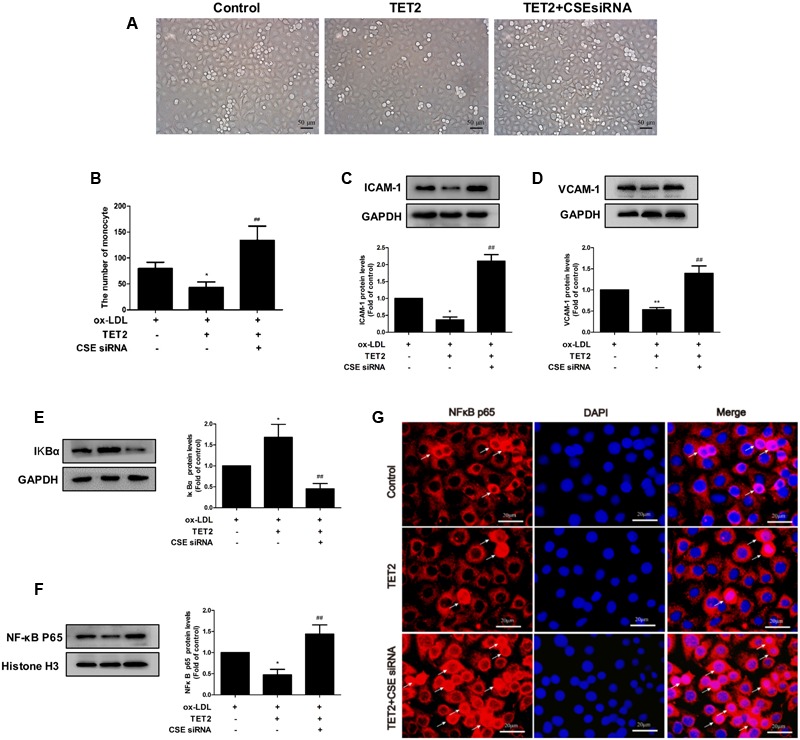
Effects of the CSE/H2S system on the TET2-induced improvement of oxLDL-treated dysfunction of HUVECs. HUVECs were transfected with or without TET2 overexpression plasmid or TET2 overexpression plasmid + CSE siRNA in the presence of oxLDL for 24 h. (A,B) Representative microscopic images of the adhesion of THP-1 cells to HUVECs (A) and quantitative analysis of adhesion results. Data are the mean ± SEM of results from at least three independent experiments. (B). The ICAM-1 (C) and VCAM-1 (D) proteins were evaluated by western blot analysis in each group of cells. The levels of IkBα protein (E) and nuclear NF-κB p65 protein (F), respectively, were examined by western blot analysis in each group of cells. (G) Distribution of NF-κB p65 protein expression was detected by immunostaining in each group of cells. NF-κB p65 positive staining is red. NF-κB p65 accumulation in the nuclei of the cells shows pink. DAPI staining is blue. Scale bar = 20 μm. All results are expressed as the mean ± SD of three independent experiments. ∗P < 0.05, ∗∗P < 0.01 vs. oxLDL-treated alone group. ##P < 0.01 vs. TET2 overexpression plasmid-treated group.